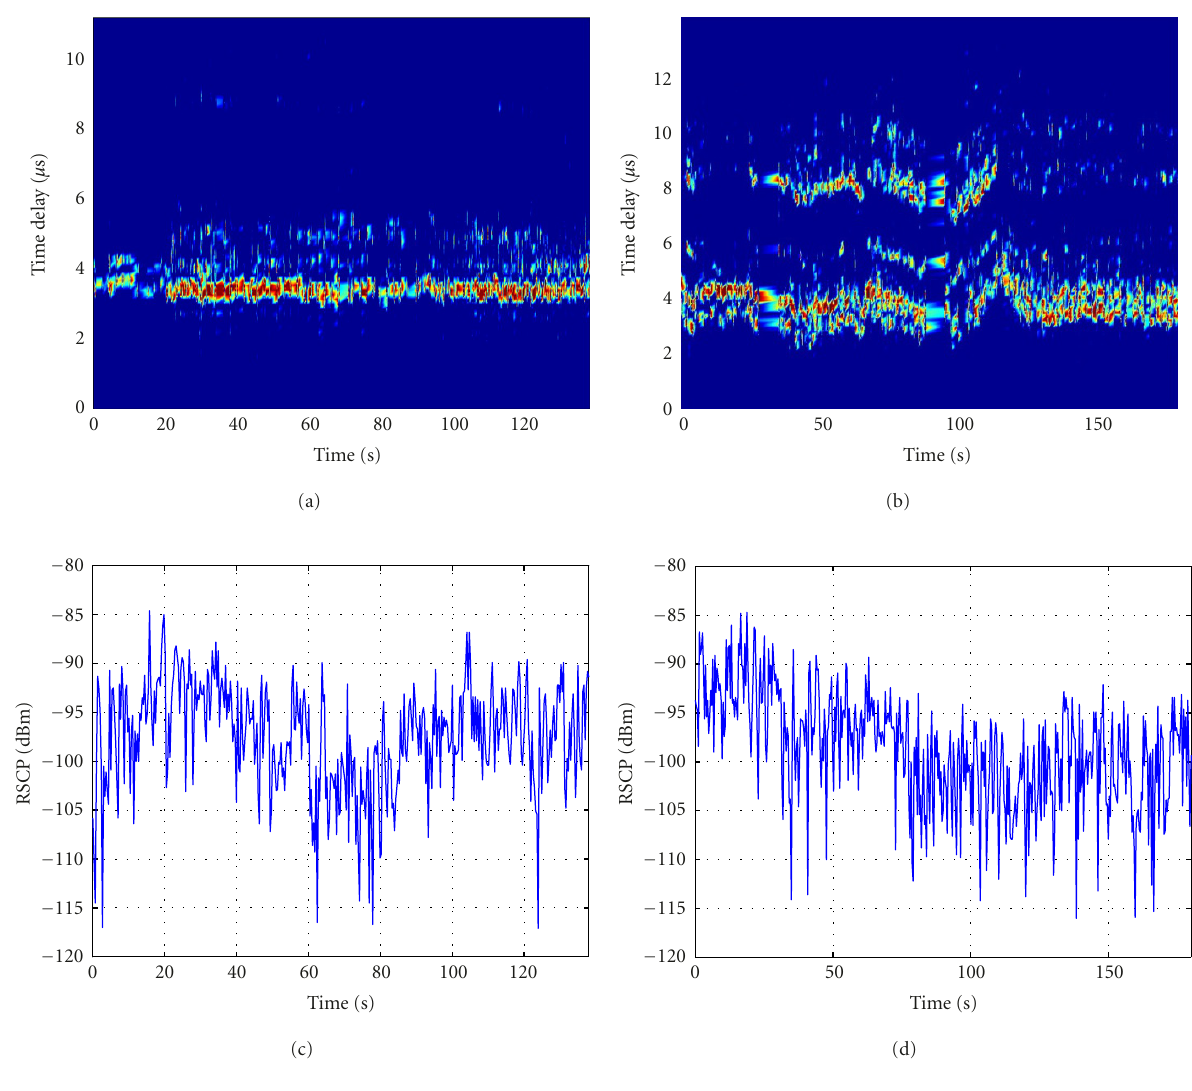
Figure 12: (a) and (b) Impulse responses and (c) and (d) received code power along the measurement routes in areas 2 and 3, respectively. received code powers are presented when transmitting at a fixed UE power level (24 dBm). The impulse response for area 2 (Figure 12a) has mainly one dominating path while for area 3, multiple paths are dominating. The measured impulse responses for the selected test system coverage area show that the trial environment can be classified as typical urban from a radio propagation modeling